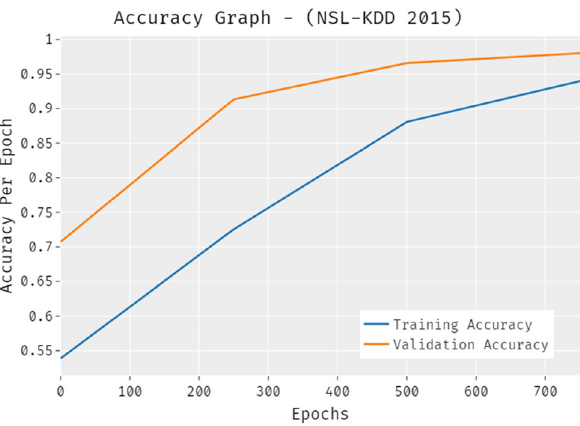
Figure 7. Accuracy analysis of PRO-DLBIDCPS technique NSL-KDD-2015